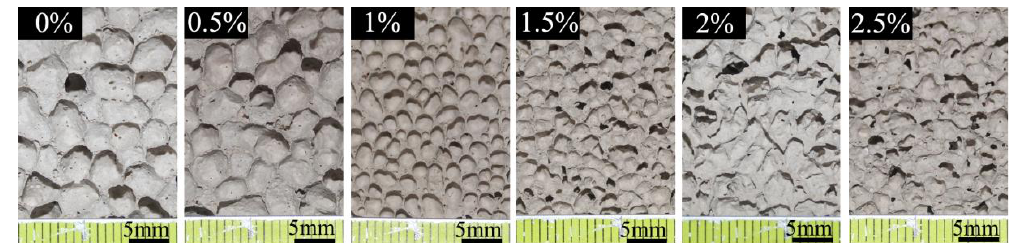
Figure 7. Surface morphology of specimens with different calcium stearate.